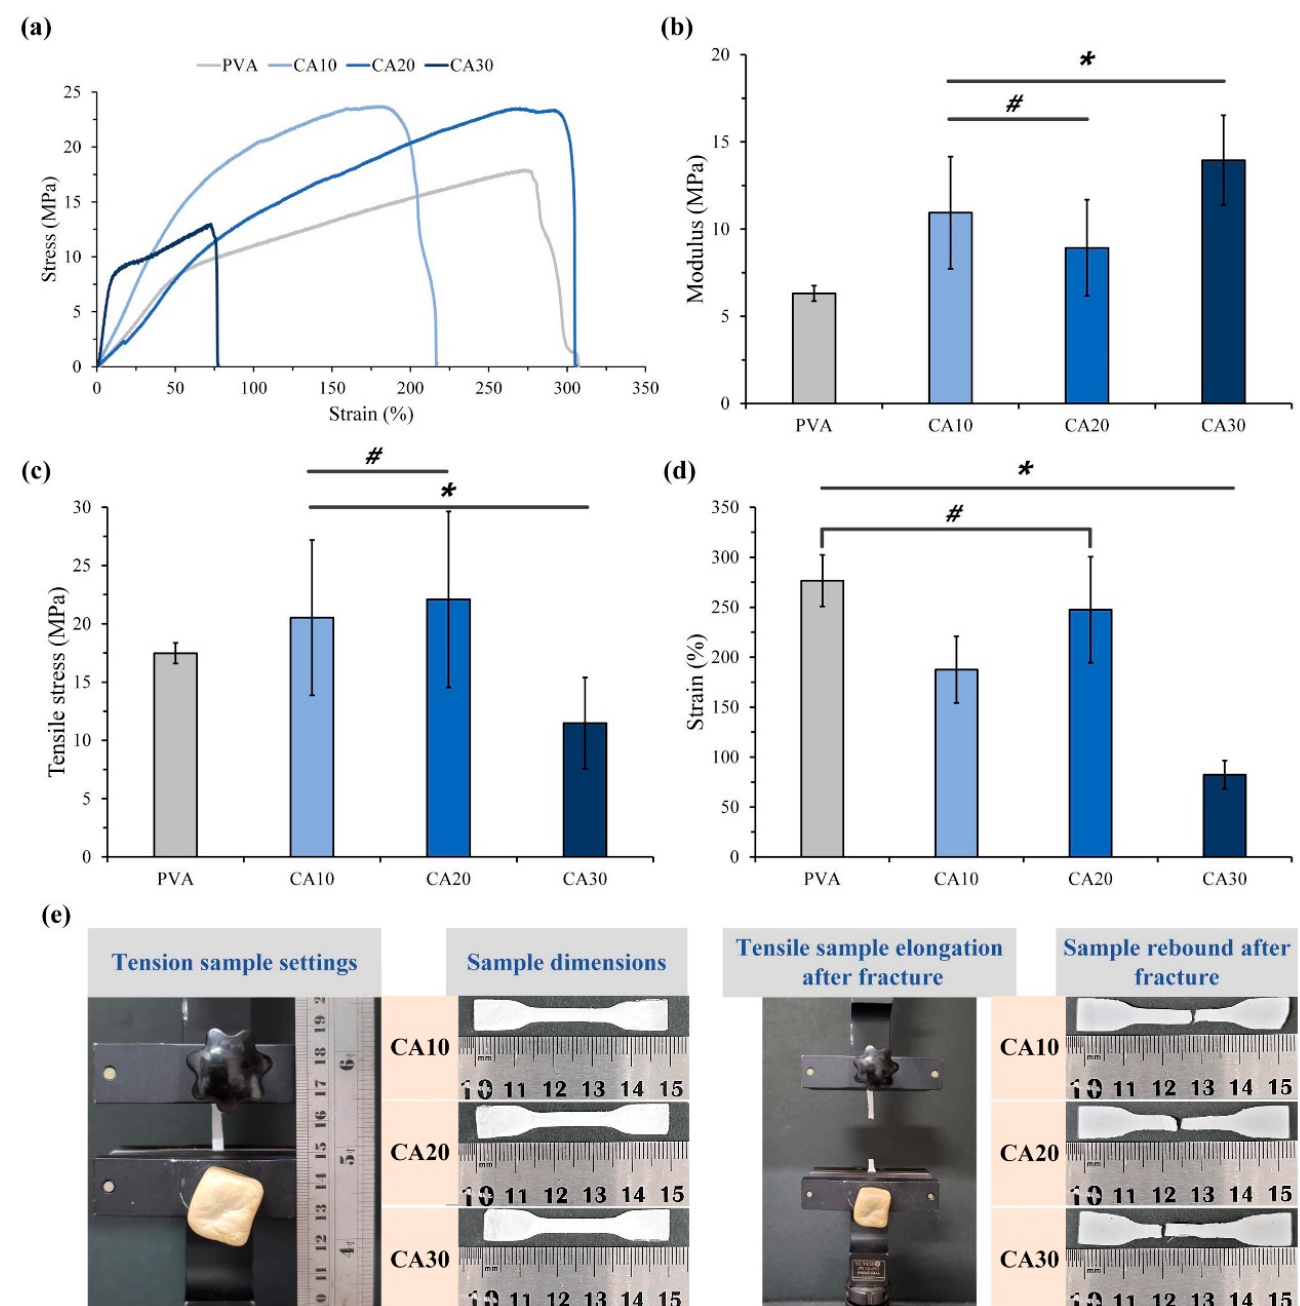
Figure 3. Tensile test results for PVA without crosslinks and CA10, CA20, and CA30 of PVA post- crosslinked membranes ( n = 6; vertical error bars represent uncertainty (standard deviation) in pa- rameter CA, * indicates signi fi cant di ff erence at p < 0.05 and # means the two groups were not sta- tistically signi fi cant at p > 0.05): ( a ) typical tensile stress–strain curves, ( b ) measured modulus, ( c ) values of tensile strength, ( d ) failure strain, and ( e ) sample dimensions, sample morphologies, and samples before and after tensile fracture (images left to right).